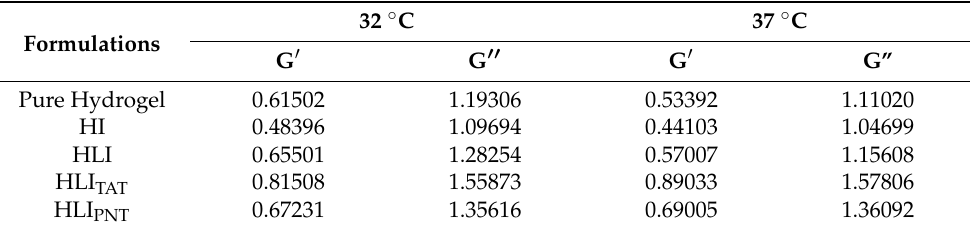
Table 2. G (cid:48) and G (cid:48)(cid:48) values of the oscillatory analysis for the formulations at 32 ± 0.5 ◦ C and 37 ± 0.5 ◦ C (n =